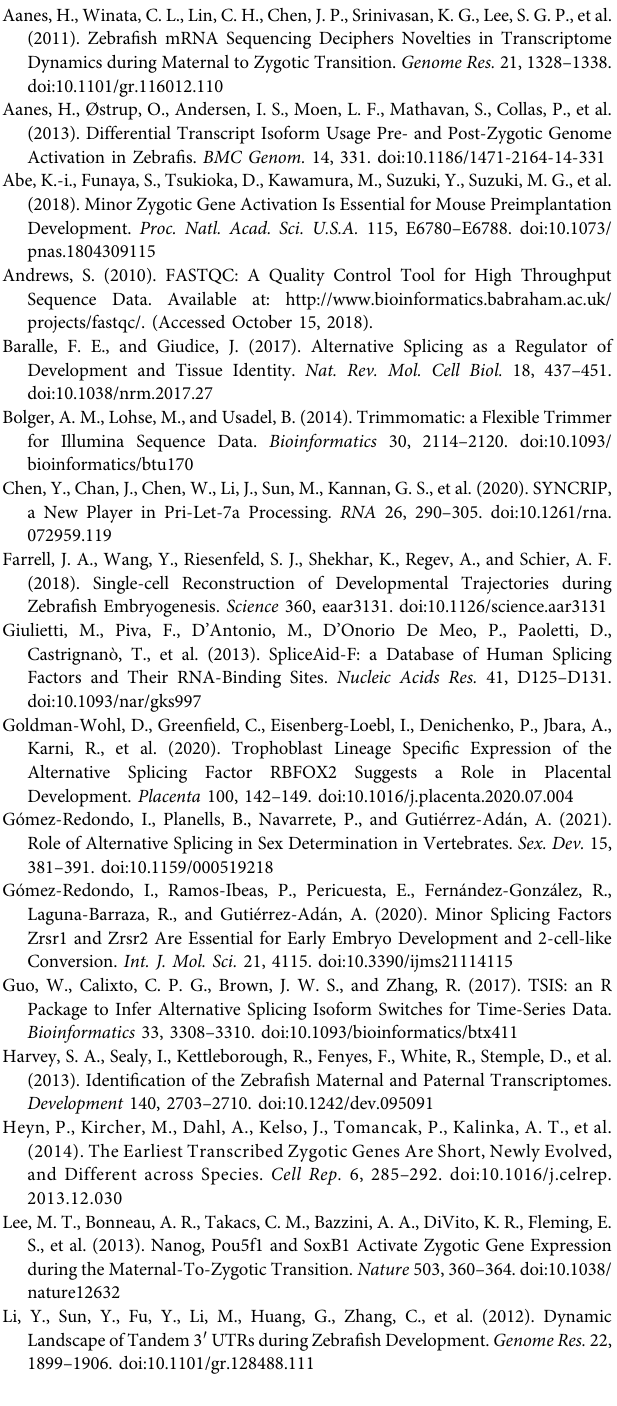
Supplementary Table S4 | Frequency of differential alternative splicing events between any two points in 18 developmental stages. In sheet1, the total number of differential alternative splicing events between any two developmental stages was provided. In sheet2, the number of differential alternative splicing events of different AS patterns between any two developmental stages was